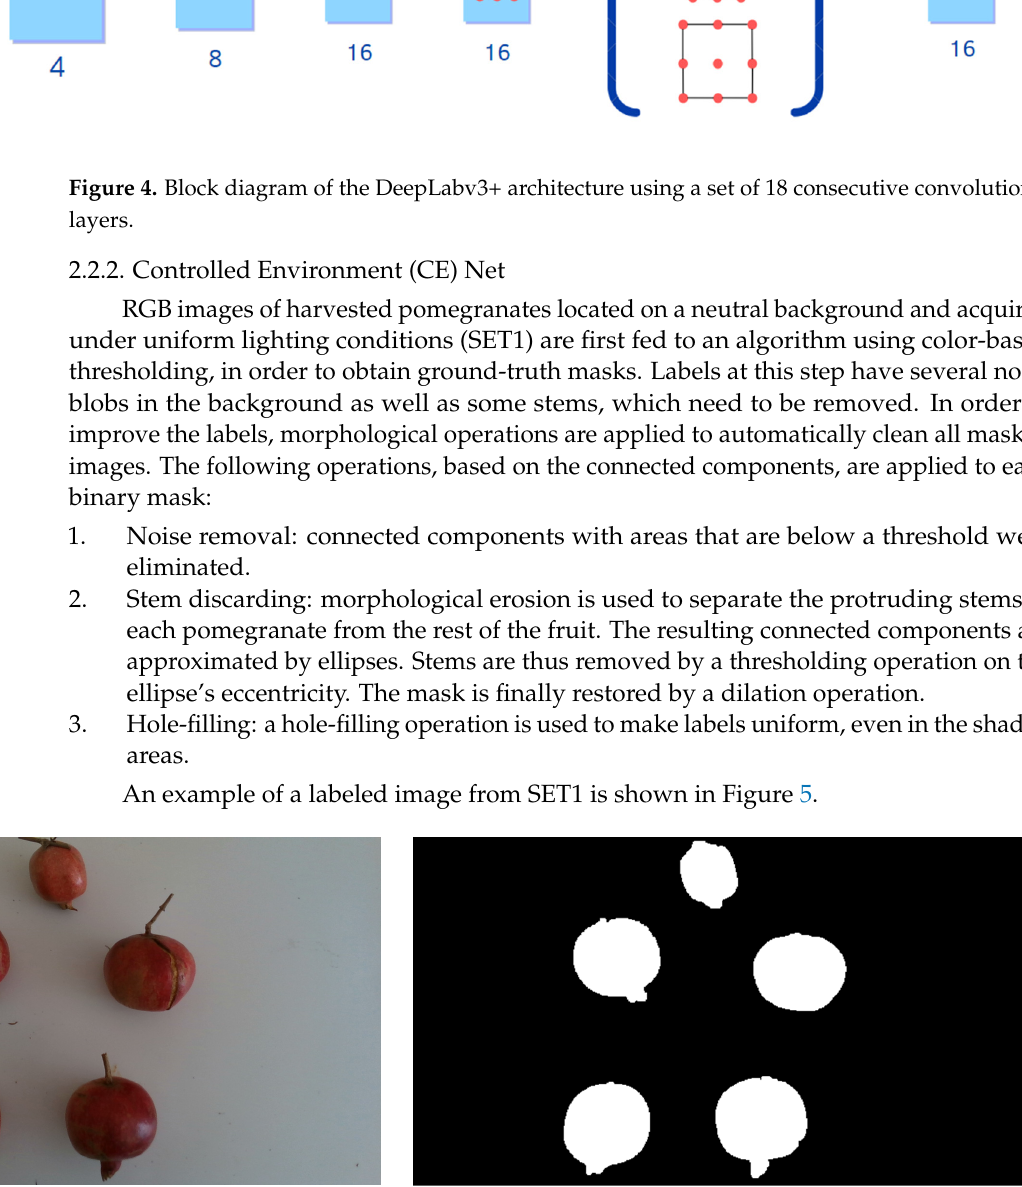
Figure 4. Block diagram of the DeepLabv3+ architecture using a set of 18 consecutive convolutional layers.